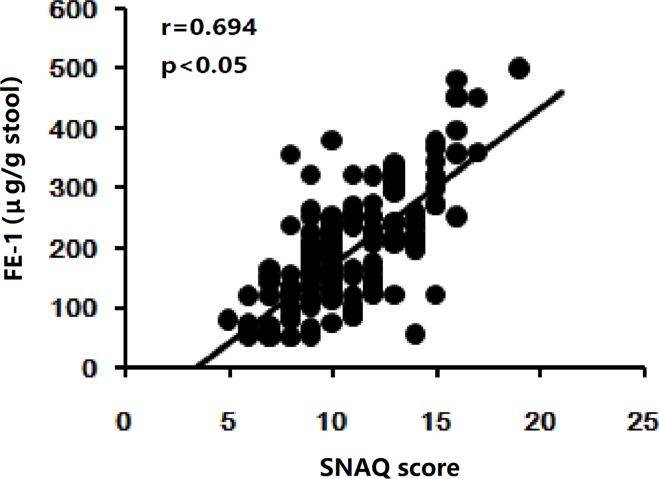
The correlation between SNAQ scores and FE-1 levels was also analyzed in patients with CHF.Spearman coefficient was used for measuring linear correlation between variables. A positive correlation was found between SNAQ scores and FE-1 (r = 0.694, p < 0.001).